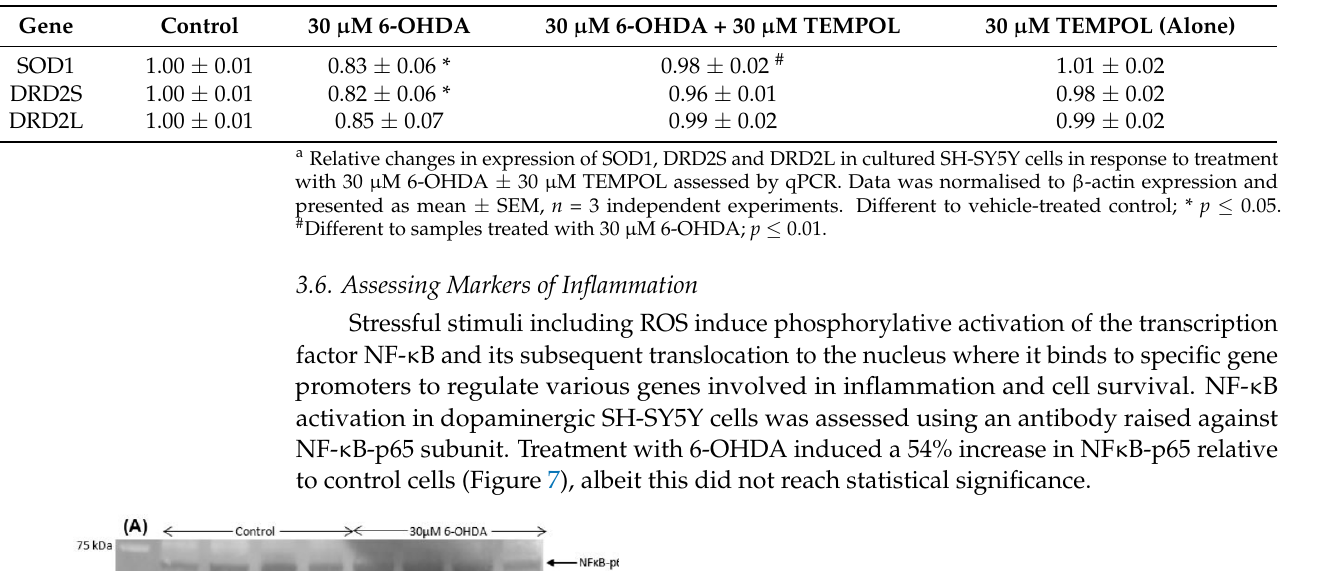
Table 2. Relative expression of selected genes in cultured SH-SY5Y cells treated with 6-OHDA ± TEMPOL a .